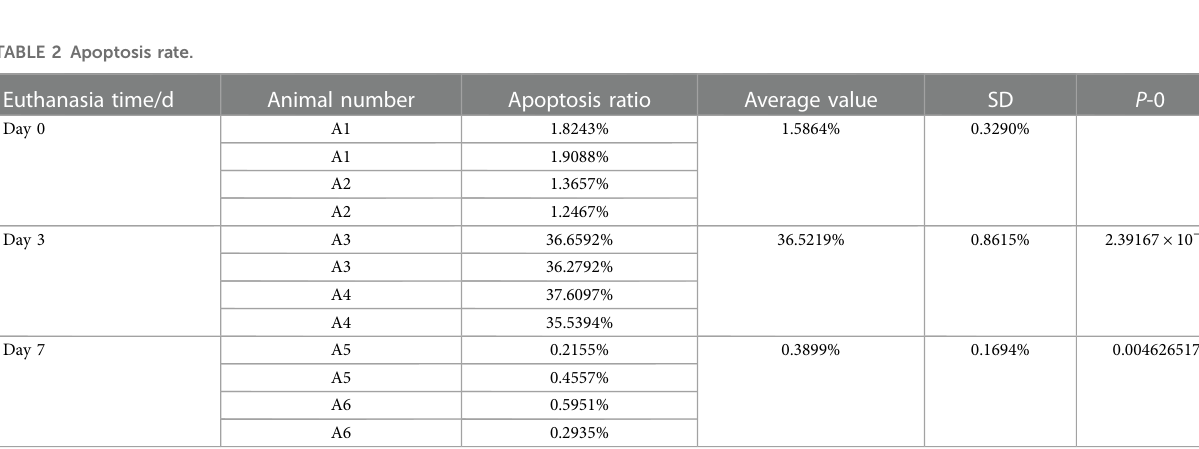
TABLE 2 Apoptosis